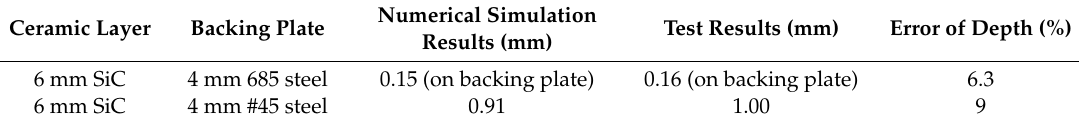
Table 2. Comparison between numerical simulation and experimental residual penetration depth on RHA witness plate under the penetration condition of 7.62 mm Armor Piercing Incendiary (API).